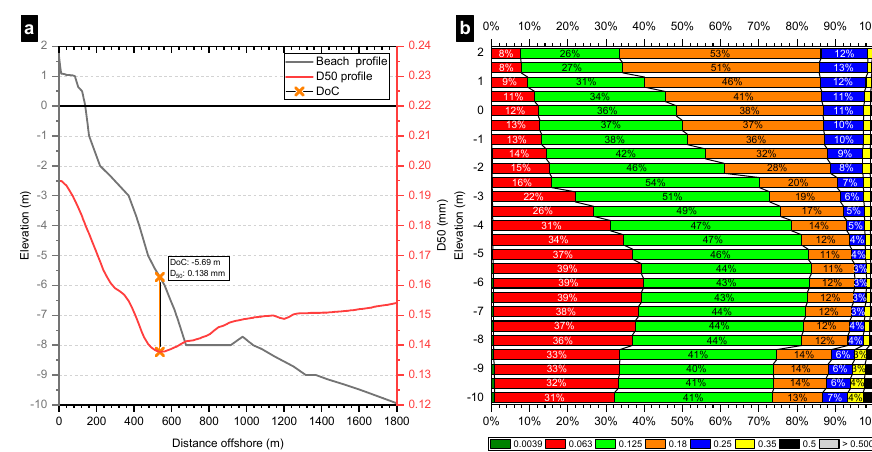
Figure 7. ( a ) Beach profile and median sediment size (D 50 ) profile with depth of closure (DoC) marked. ( b ) Grain size distribution with depth.